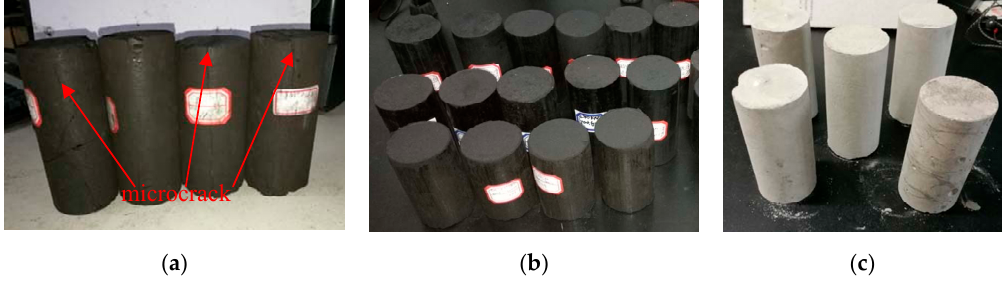
Figure 1. Coal and rock specimens. ( a ) Raw coal; ( b ) shaped coal specimens and ( c ) cement